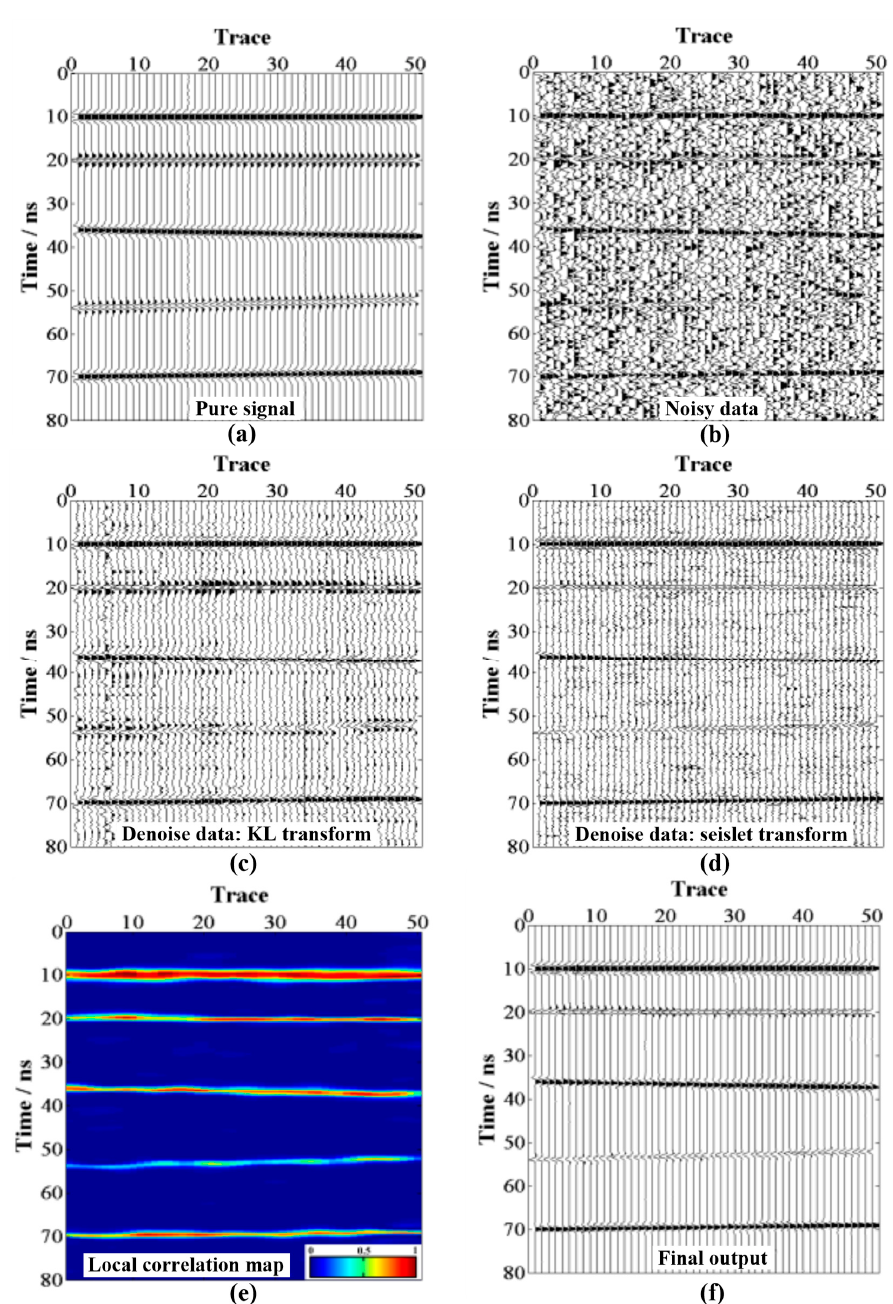
Figure 6. Demonstration of weak signal extraction. ( a ) Signal; ( b ) Noisy signal; ( c ) Pre-denoised result: K-L transform; ( d ) Pre-denoised result: ST; ( e ) Local correlation map of ( c , d ); ( f ) Extracted signal using our